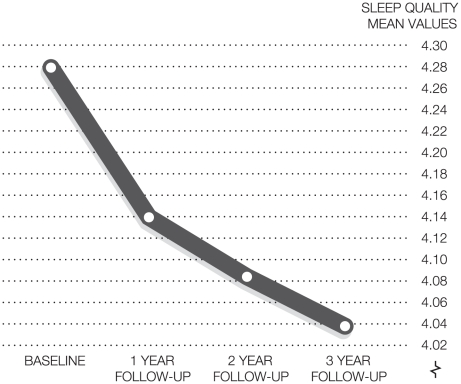
Repeated measures ANOVA illustrating the deterioration in sleep quality mean values over time. (n = 846).